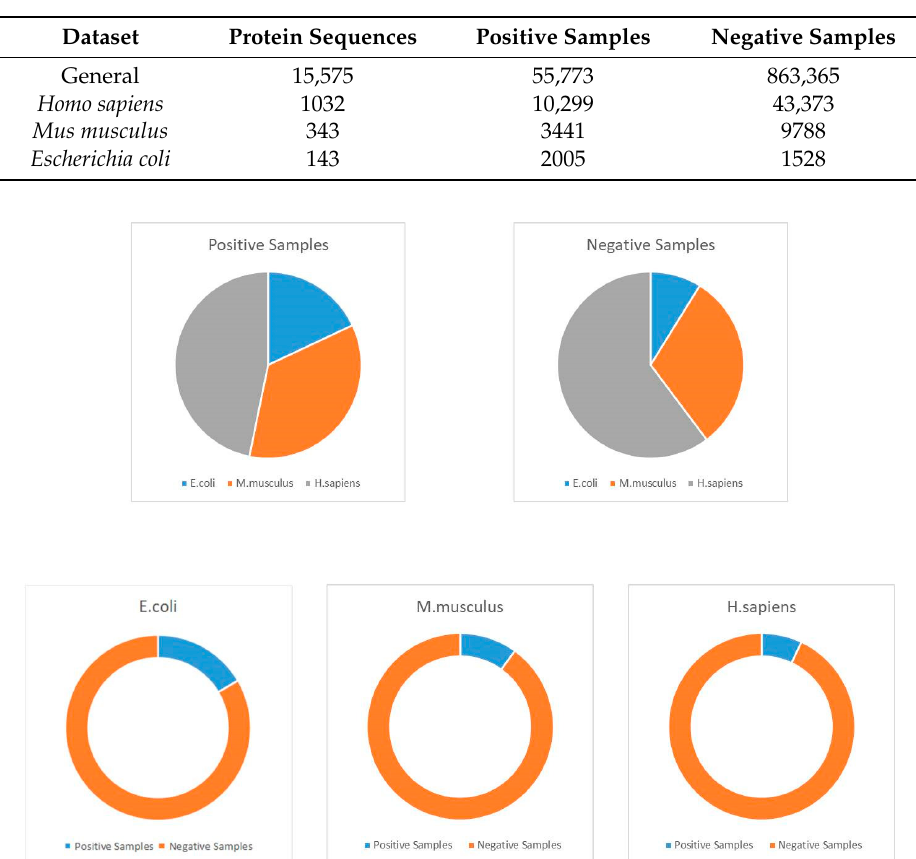
Table 9. Detailed information of employed datasets.